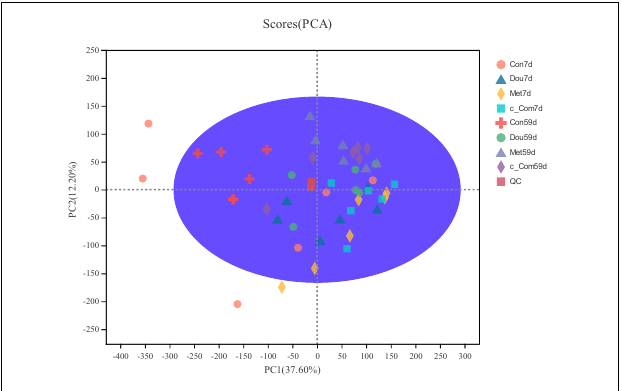
FIGURE 1 | Primcipal component analysis score chart. After dimension reduction analysis, there are relative coordinate points on principal components P1 and P2, and the distance of each coordinate point represents the degree of aggregation and dispersion between samples. The confidence ellipse means that the "real" samples group is distributed in this region with 95% confidence.